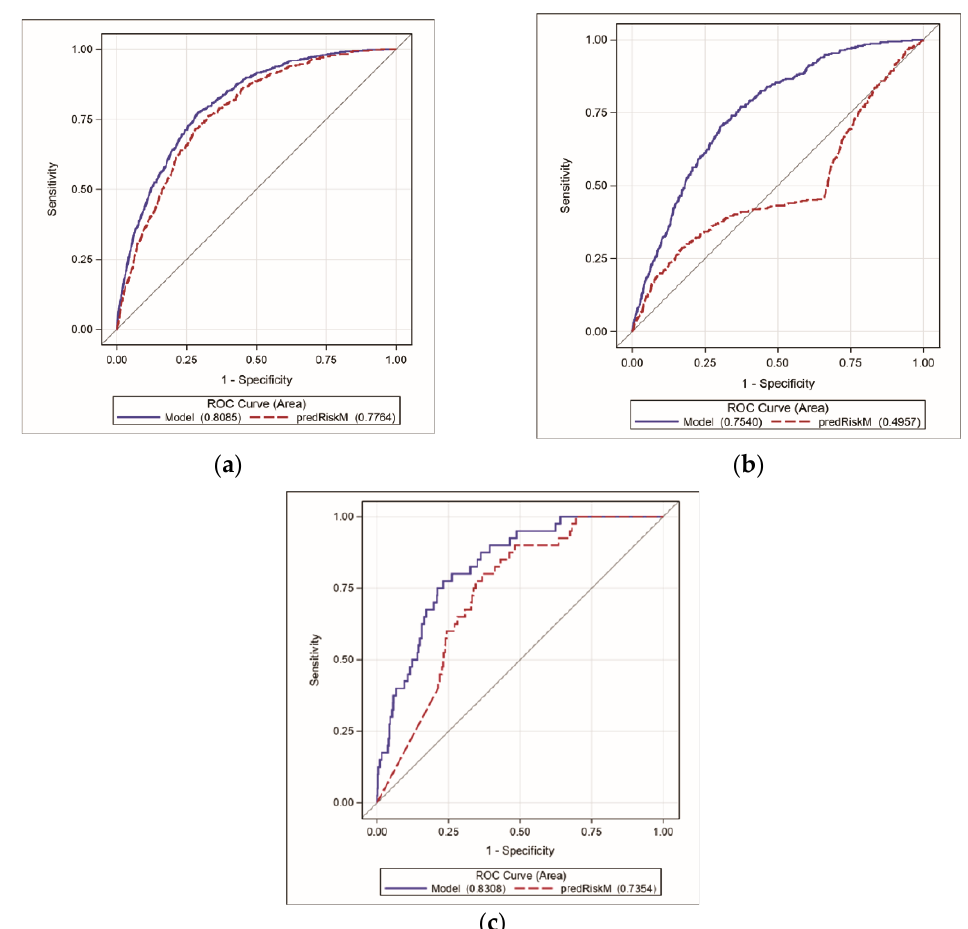
Abbreviations. BMI = body mass index; CVD = cardiovascular disease; DM = diabetes; HDL-C = high-density lipoprotein- cholesterol. a T- and Chi-squared tests were used for continuous and categorical characteristics, respectively. b VA women CVD risk score (Jeon-Slaughter et al., 2021 [6]).